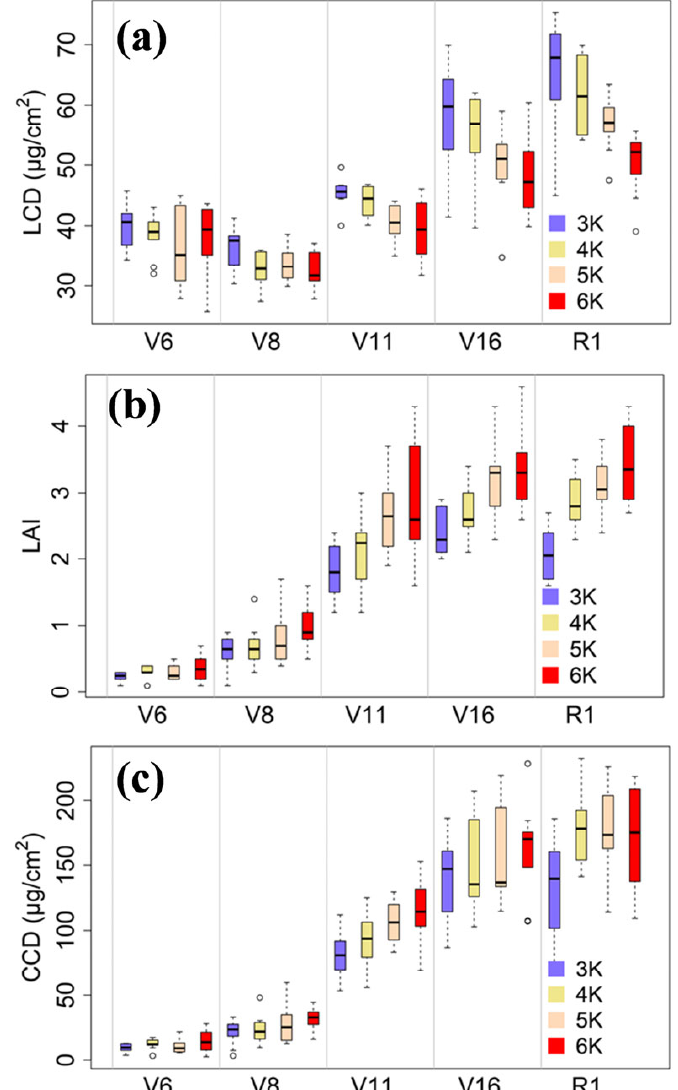
Figure 5. Box plot of ground measured data varying with density. ( a – c ) represent the distribution of LCD, LAI and CCD along with the growth stage and planting density respectively. The 3K, 4K, 5K, and 6K represent the four planting densities, respectively.